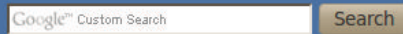
Figure 6: Examples of interactive